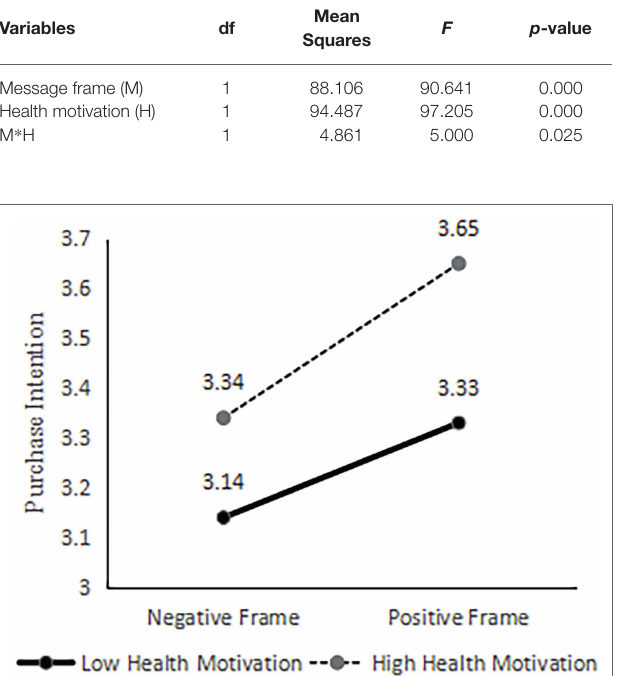
FIGURE 2 | Moderating effect of health motivation level on framing effect.